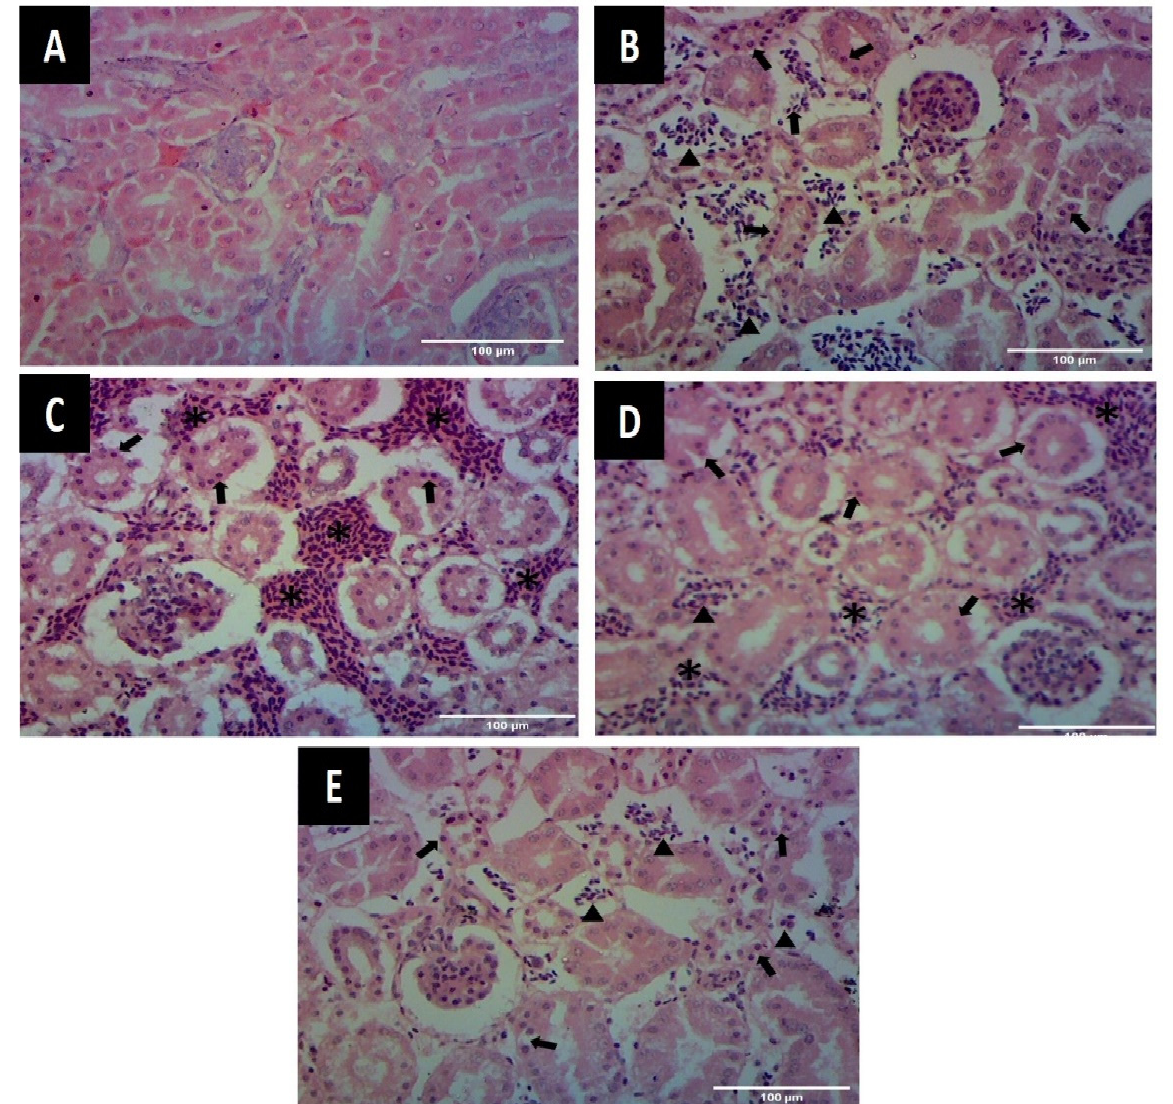
Figure 4. Photomicrographs of kidneys showing microscopic changes ( A ) Kidney from group A showing normal appearance of tubular epithelial cells and glomeruli (H&E staining 400 × ) ( B ) Kidney from group B showing presence of mononuclear cells and RBCs (arrow heads) and necrosis of tubular epithelial cells (arrows) (H&E staining 400 × ) ( C ) Kidney from group B showing areas of congestion (asterisk) and necrosis of tubular epithelial cells (arrows) (H&E staining 400 × ) ( D ) Kidney showing necrotic tubular epithelial cells (arrows), presence of mono-nuclear cells (arrow heads) and congested areas (asterisk) in group D (H&E staining 400 × ) ( E ) Kidney from group C showing the presence of few mononuclear cells (MC) and RBC (arrow heads) along with darkly stained nuclei of tubular epithelial cells at few places (arrows) (H&E staining 400 × ). Jejunum In group A, jejunal villi appeared normal with intact epithelium and goblet cells throughout the length (Figure 5A). In group B, jejunal epithelium appeared disrupted with damaged villi and few goblet cells (Figure 5B). In groups C and D, villi showed intact epithelium with fine development, goblet cells and normal submucosa (Figure